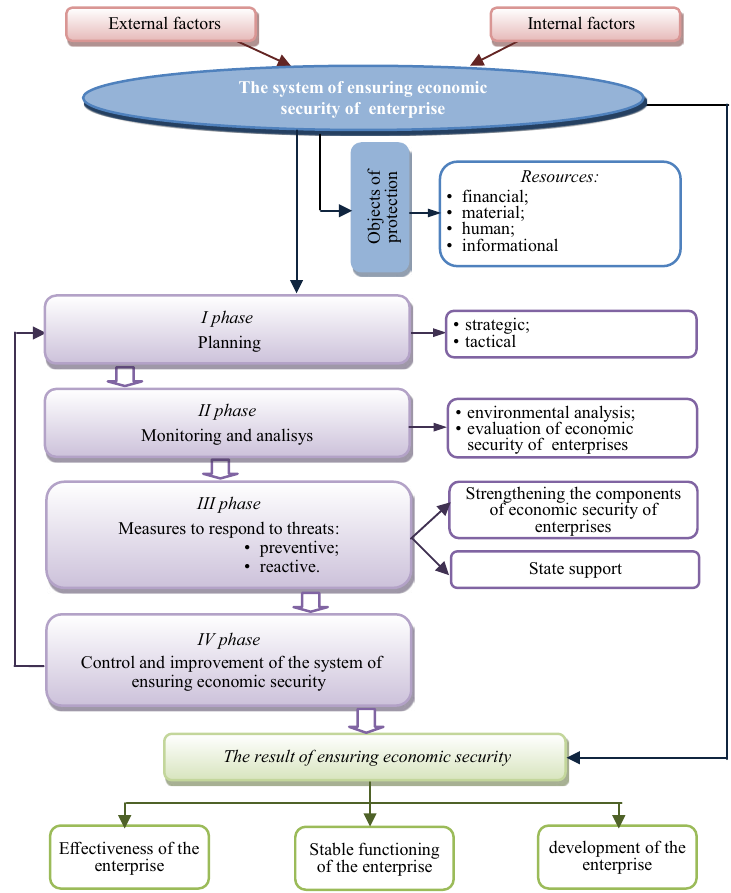
Fig. 3. System of ensuring economic security of the enterprise Source : compiled by